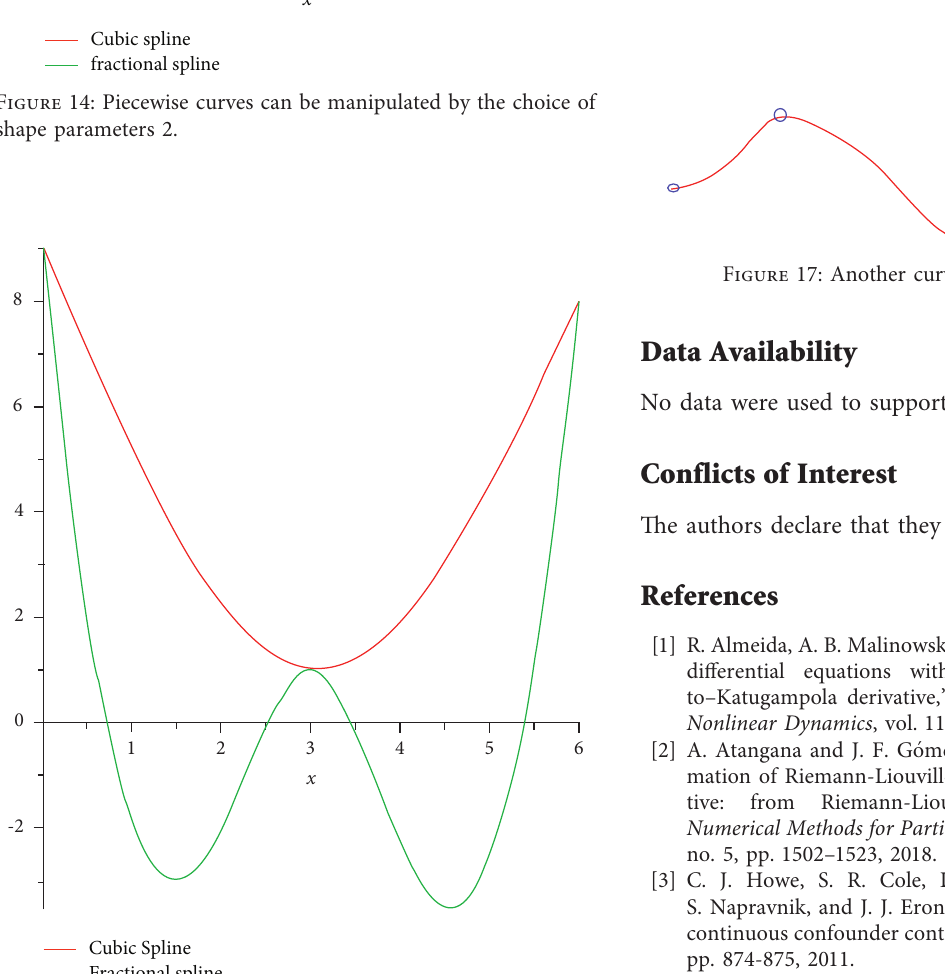
Figure 16: Curve segments.